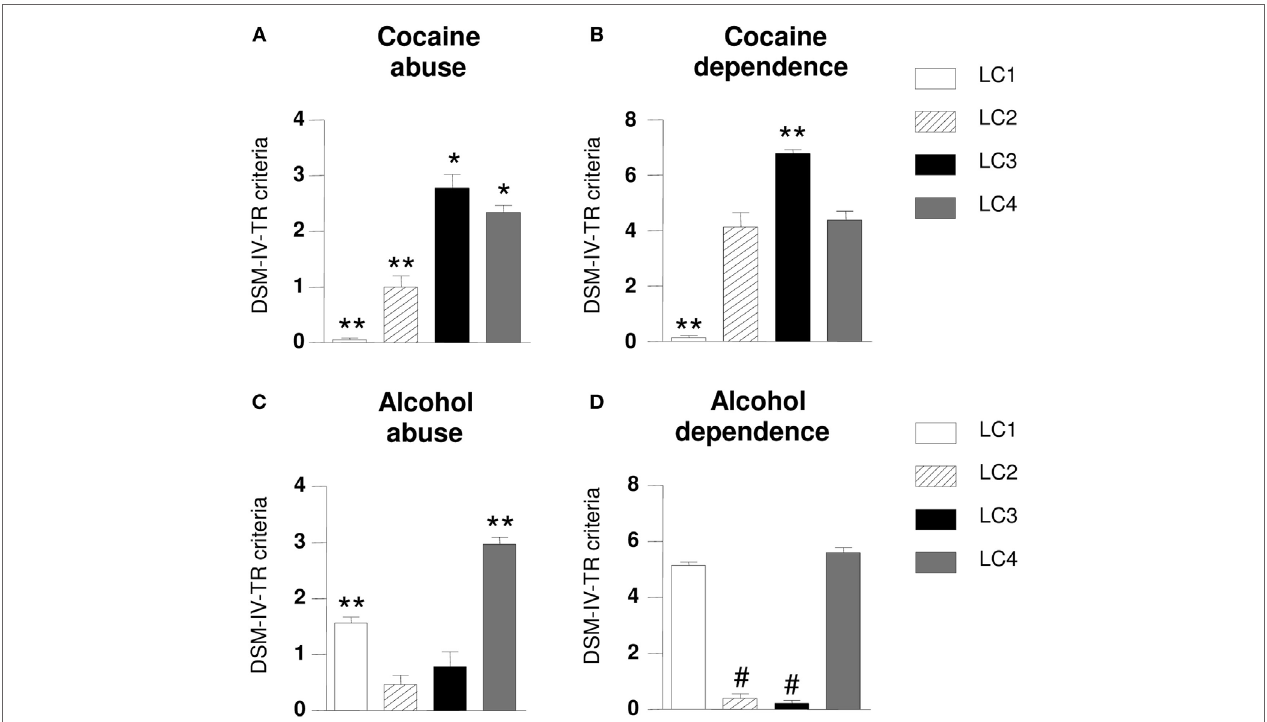
FigUre 2 | Differences in Diagnostic and Statistical Manual of Mental Disorders-4th Edition-Text Revision (DSM-IV-TR) criteria for substance use disorders according to latent classes (LCs). Abuse diagnosis was based on four DSM-IV-TR criteria, while dependence diagnosis was based on seven criteria. LC3 patients met more cocaine abuse criteria than other classes (a) ; LC3 patients met more cocaine dependence criteria than other classes (b) ; LC4 patients met more alcohol abuse criteria than other classes (c) ; LC4 patients met more alcohol dependence criteria than other classes (D) . Average criteria = DSM-IV use disorder criteria. Data are expressed as the mean ± SEM. Post hoc Newman–Keuls comparisons: difference vs. the other three groups: * p ≤ 0.05; * *p ≤ 0.001; difference vs. LC 1 and LC4: # p ≤ 0.001.